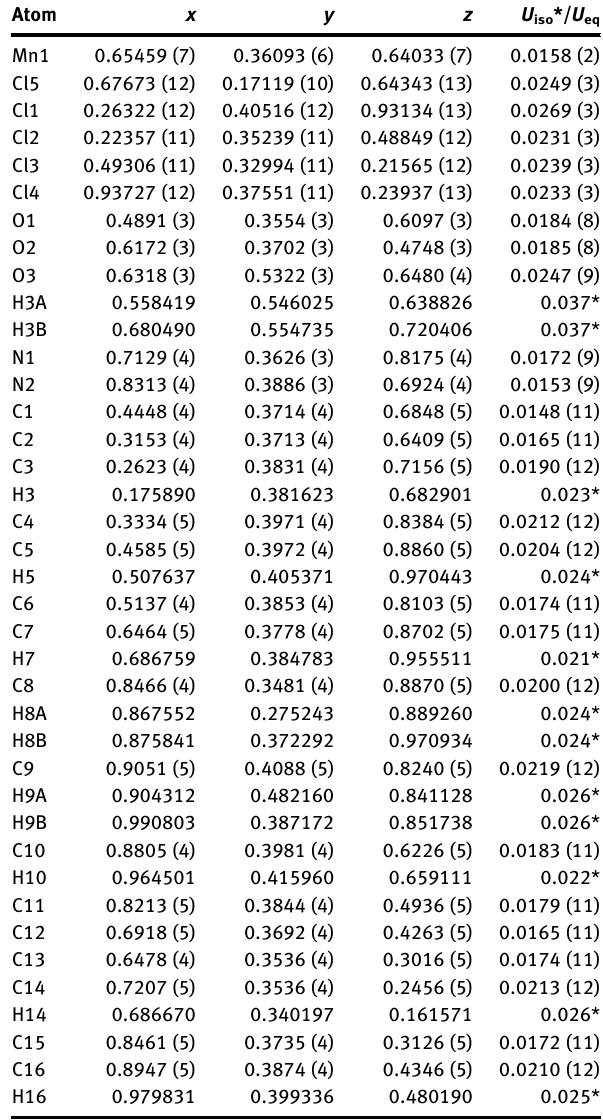
Table  : Fractional atomic coordinates and isotropic or equivalent isotropic displacement parameters (Å 